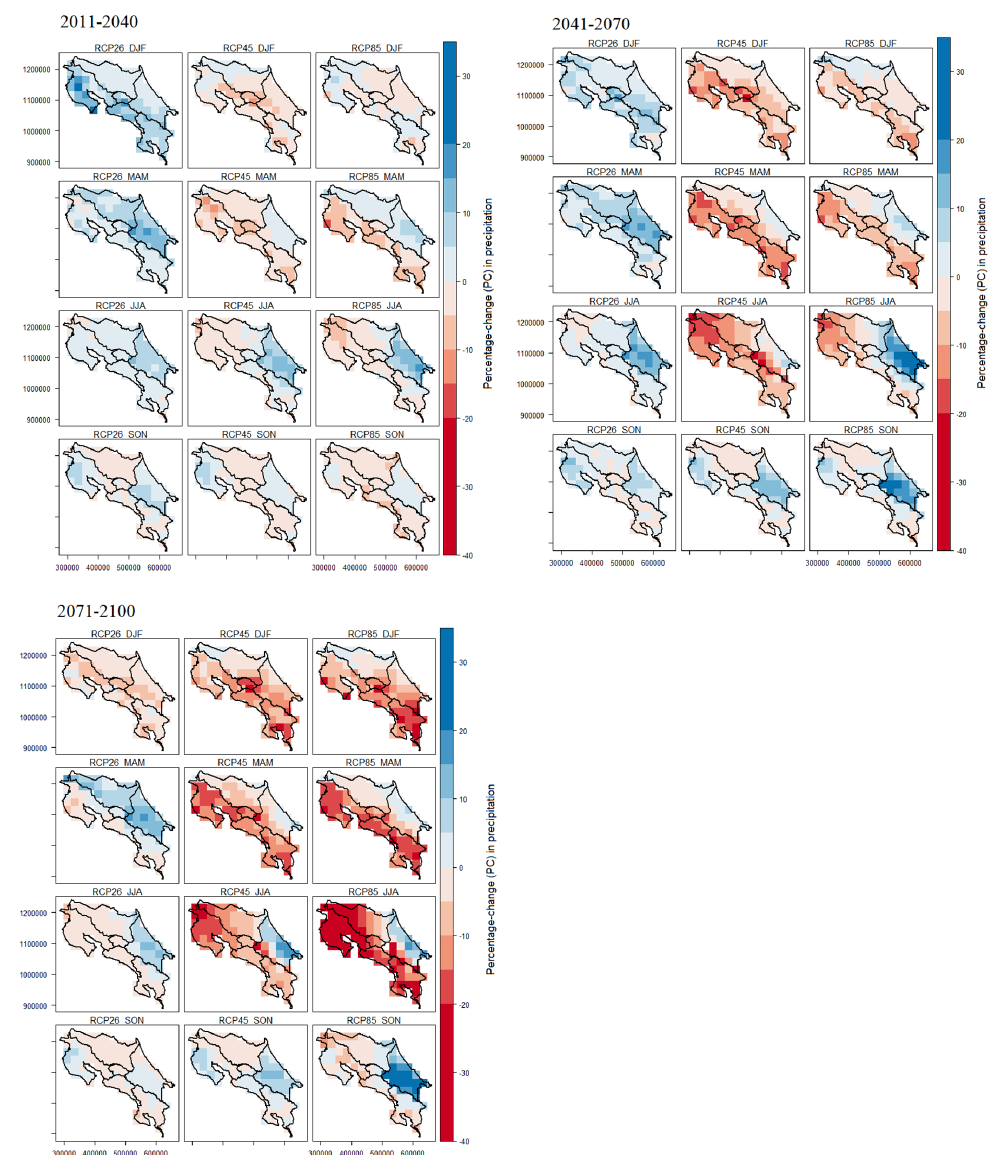
Figure 12. Spatially-distributed percentage-change (PC) in precipitation of the bias corrected ensemble-mean with respect to baseline period (1961–1990) under RCPs 2.5, 4.5 and 8.5 for near-future, mid-future and far-future periods over all climatic regions of Costa Rica.